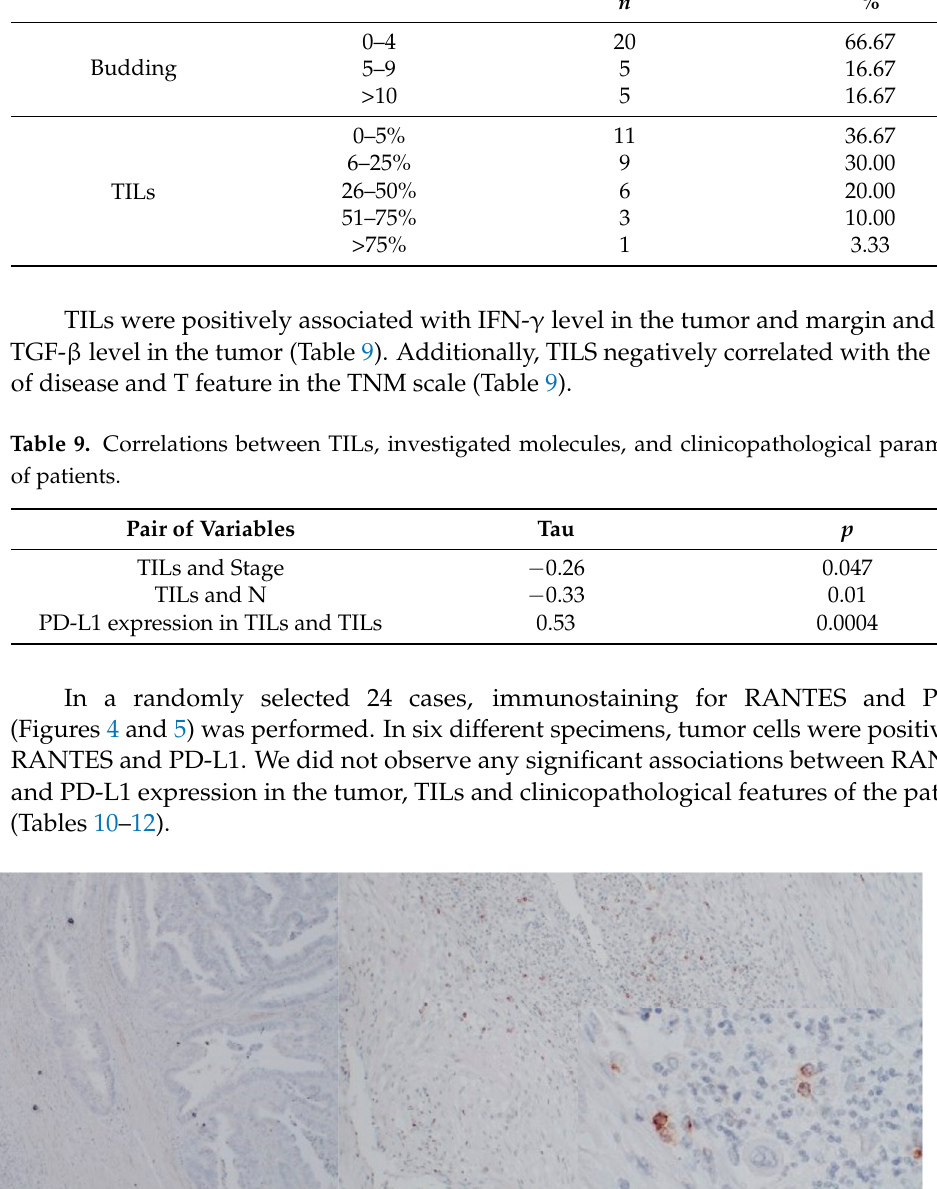
Figure 5. Immunostaining for PD ‐ L1 ((Opta Tech 2200 Camera, magnification 10× and 60×). Cyto ‐ plasmatic positive IHC staining for PD ‐ L1 in tumor ‐ infiltrating lymphocytes. Table 10. Clinicopathological parameters of patients according to RANTES expression in the tumor. Features